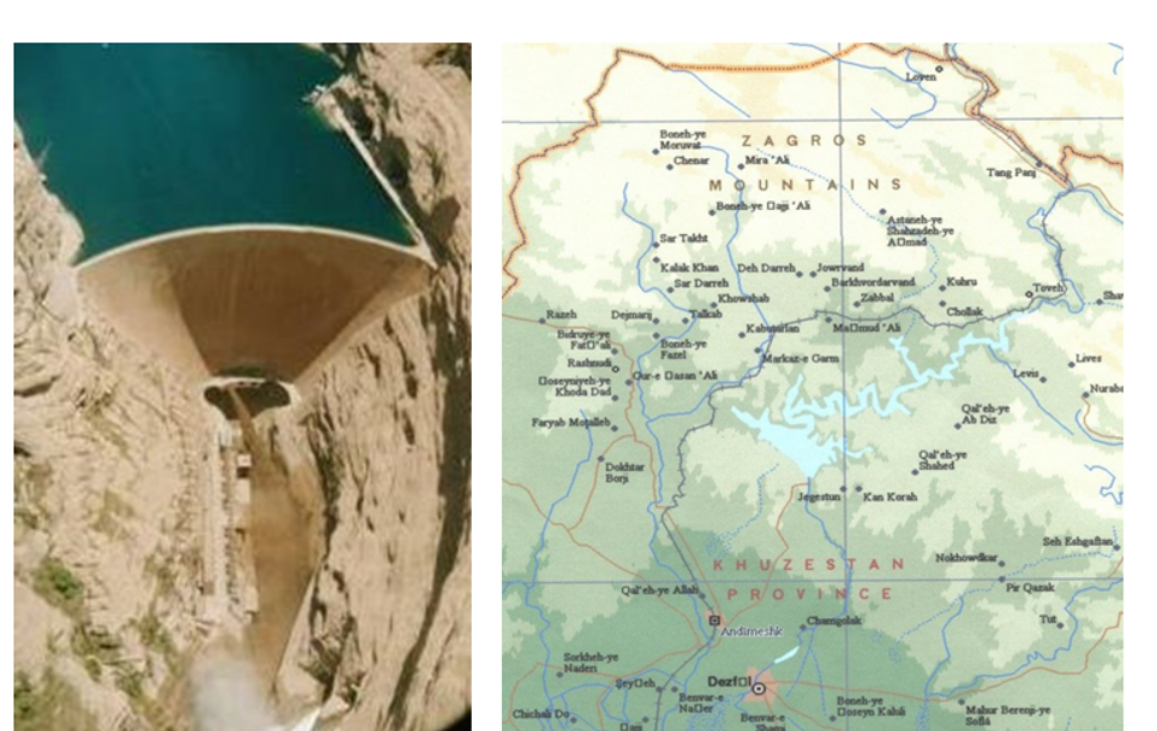
Figure 4. (a) General view of Dez Dam; (b) Location map of Dez Dam